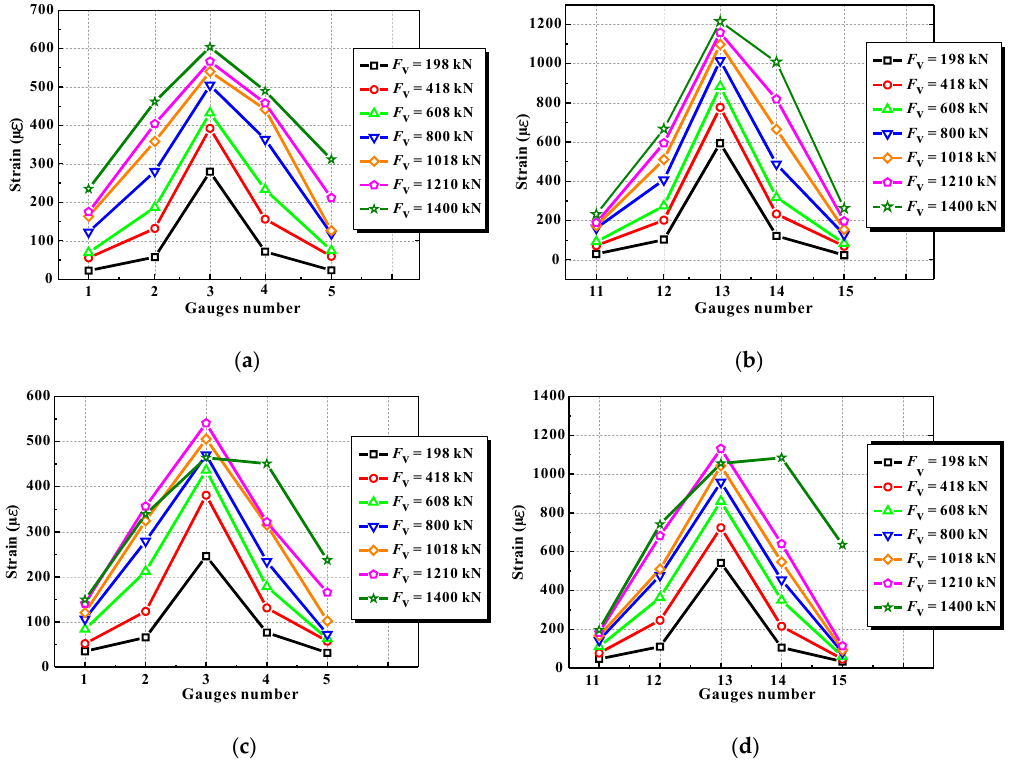
Figure 17. Measured steel strains of Specimens S60C and S120C. ( a ) Gauges 1–5 for Specimen S60C; ( b ) gauges 11–15 for Specimen S60C; ( c ) gauges 1–5 for Specimen S120C; ( d ) gauges 11–15 for Specimen S120C.